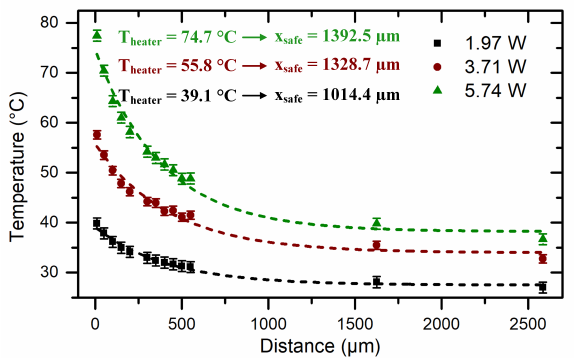
Figure 6. Comparison of the temperature profile along the reference sample for three different heating powers. It can be clearly observed that the maximum temperature increases with increasing heating